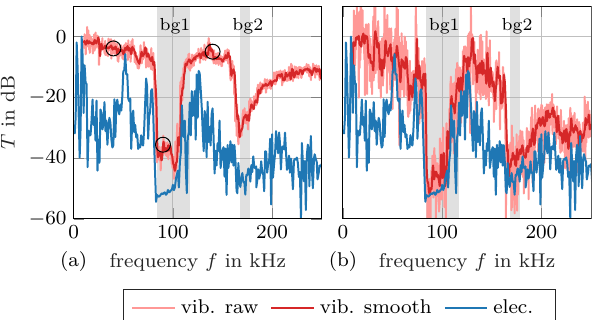
Figure 9. Measured transmission factor for Sample 1: The spatial data of the vibrometer measure- ments have been contracted with ( a ) the quadratic mean (energy transmission) and ( b ) the arithmetic mean (preserving the phase). The calculated band gaps are highlighted in grey. The circles mark the fields visualized in Figure 8.